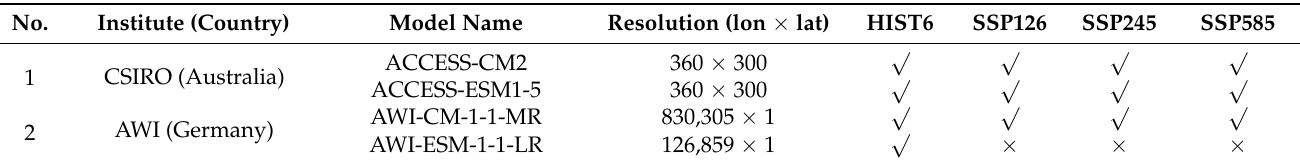
Table 1. Details of models used in CMIP6 analysis of Asia Marginal Seas